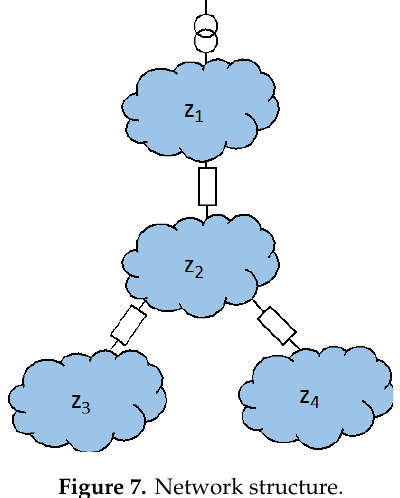
Figure 7. Network structure.